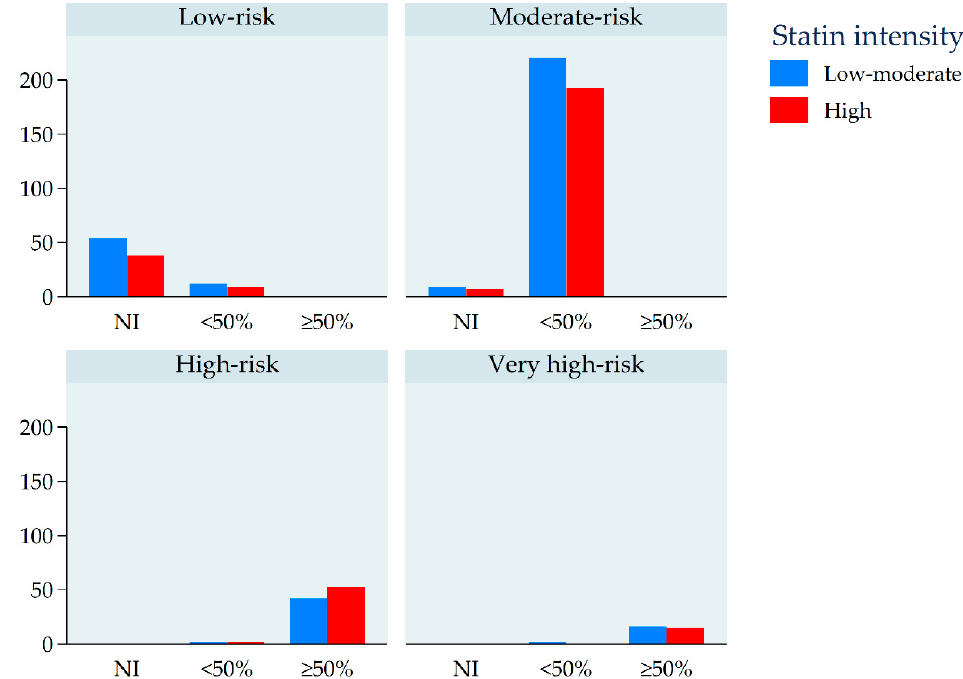
Figure 1. Numberofworkersprescribedlow–moderate-orhigh-intensitystatins, stratifiedbycardiovascular Figure 1. Number of workers prescribed low–moderate- or high-intensity statins, stratified by disease (CVD) risk and recommended management. CVD risk: classification of cardiovascular risk according cardiovascular disease (CVD) risk and recommended management. CVD risk: classification of to current European guidelines on CVD prevention, based on the combination of SCORE value and the cardiovascular risk according to current European guidelines on CVD prevention, based on the presence of other CVD risk factors. Recommended management: recommended patient management combination of SCORE value and the presence of other CVD risk factors. Recommended according to current European guidelines on CVD prevention, based on CVD risk, current LDL-cholesterol (LDL-C) levels, and target LDL-C levels. NI: drug treatment “not indicated”, only lifestyle advice